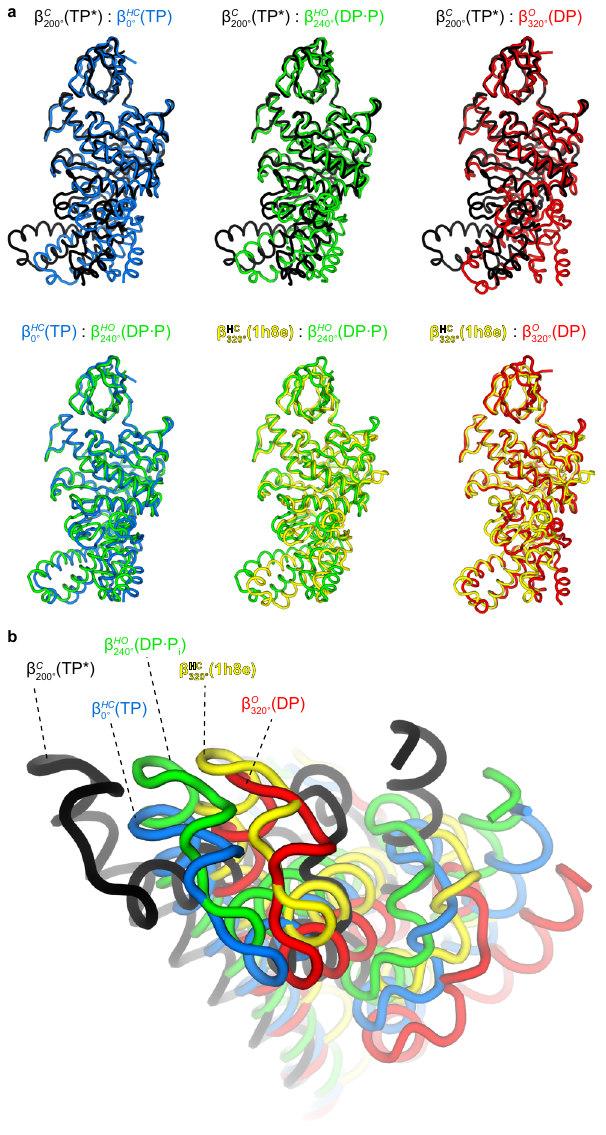
Fig. 4 Comparison of conformational states of β -subunits. Superposition (on the N-terminal β -barrel) of the four main conformational states seen in the TF 1 ( β E190D) (this study; β HC